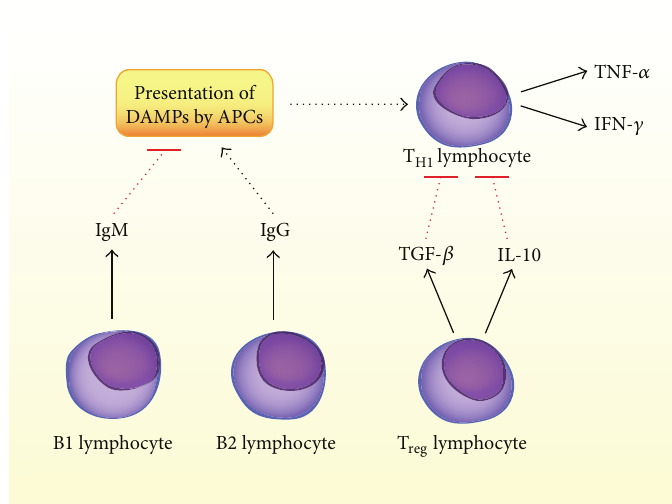
Figure 2: Summary of potential contributions by lymphocytes to IA. T- and B-lymphocytes have been identified in human IA tissue specimens, but their functions and the presence of subsets of these cells are not well characterized. IgM and IgG are present in IA, though specific populations of B1 and B2 lymphocytes have not been confirmed as the source of these immunoglobulins. Additionally, although IgG plays a proinflammatory role and IgM plays an anti-inflammatory role in atherosclerosis, these strict characterizations have not been borne lymphocytes, which express TNF- 𝛼 and IFN- 𝛾 , may be present in IA and could be activated by DAMP presentation out in models of IA. T H 1 lymphocytes may be present and could antagonize by macrophages and dendritic cells. TNF- 𝛼 plays an important role in IA pathogenesis. T reg cells through the actions of TGF- 𝛽 and T H 1